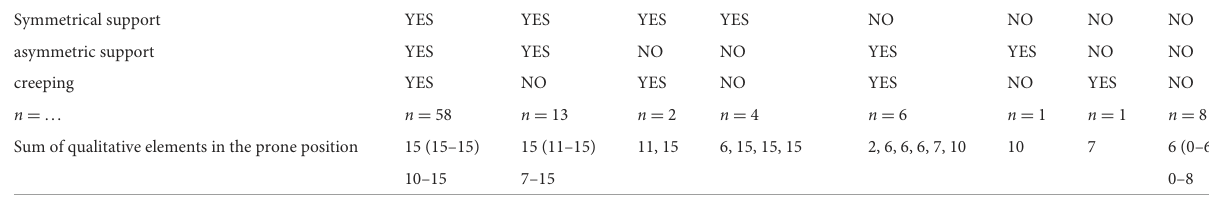
Symmetrical support YES asymmetric